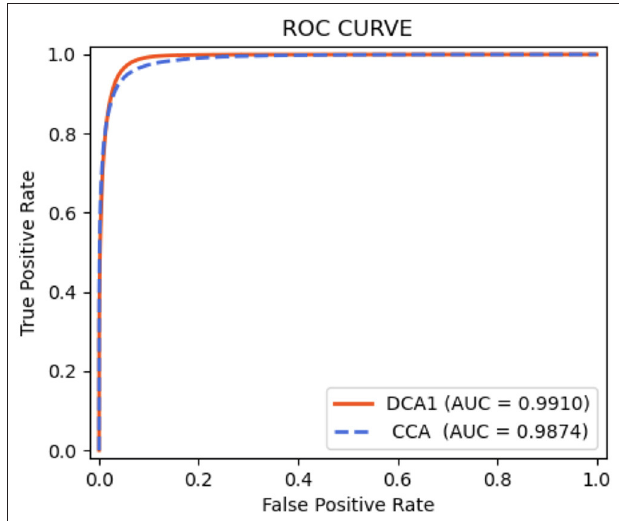
FIGURE 11 | ROC curves for DCA1 and CCA